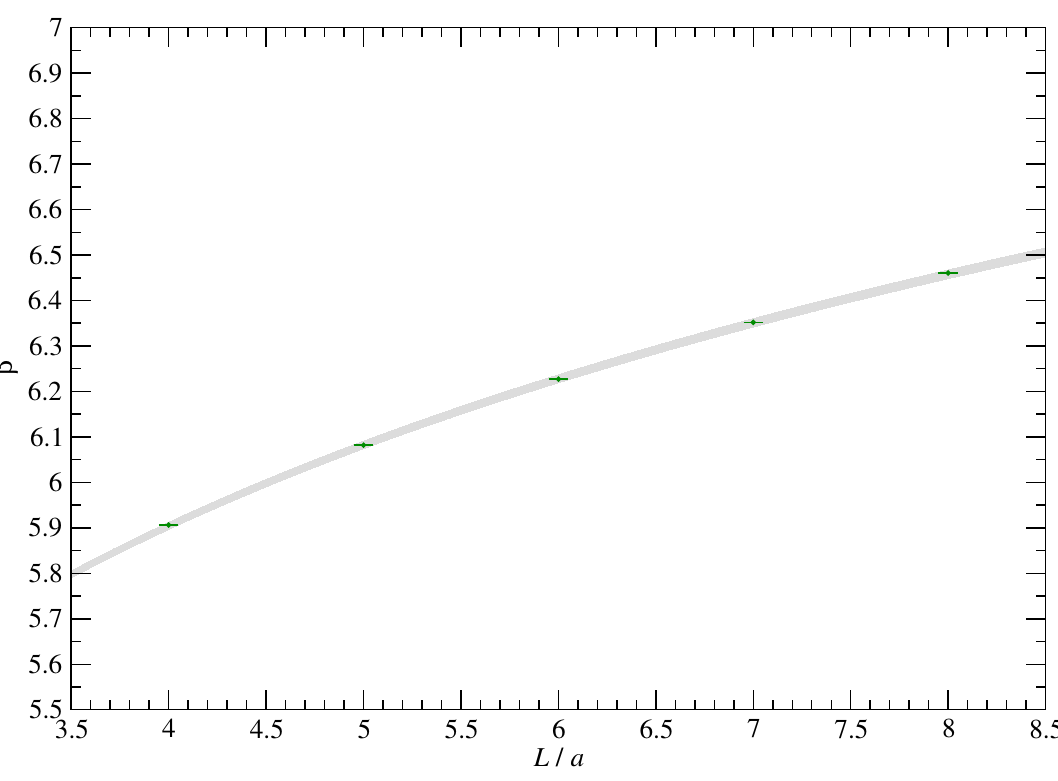
Figure 7 . The inverse-squared-bare-coupling parameter (cid:12) = 2 N=g 2 (green circles), as a function of L=a , in SU(3) Yang-Mills theory and the corresponding (cid:12)tted curve (cid:12) = 4 : 797(6) + 0 : 798(4) (cid:1) ln( L=a ), with the associated uncertainty (gray band).